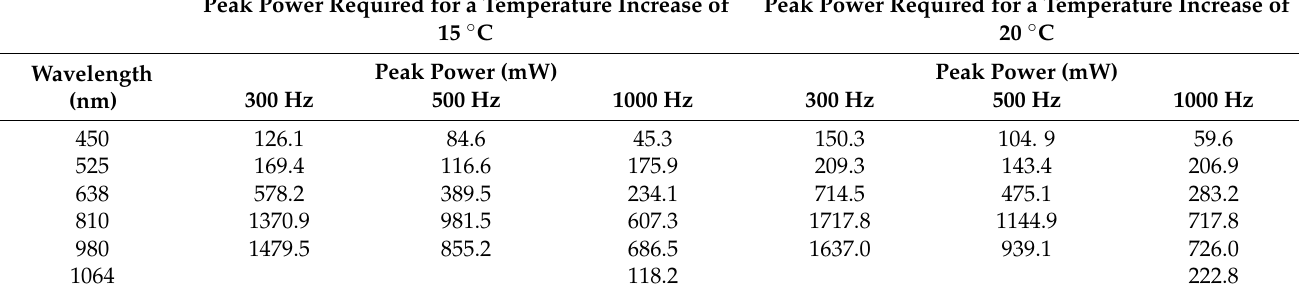
Table 1. The peak power required to increase the temperature of the thermocouple junction area for different pulse frequencies for the pulsed lasers with different